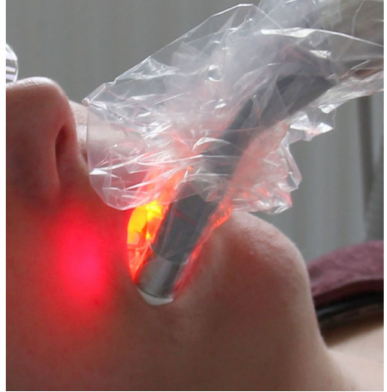
Figure 3. Exposure of a participant with VIS +